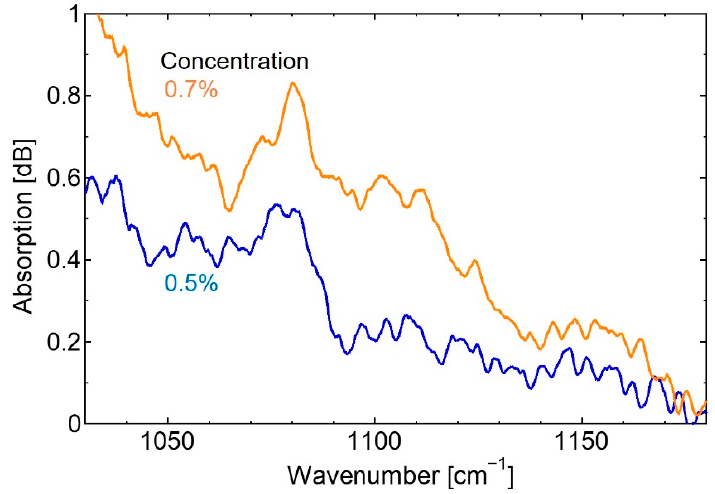
Figure 5. Absorption spectra of the glucose solution after changing the prism.